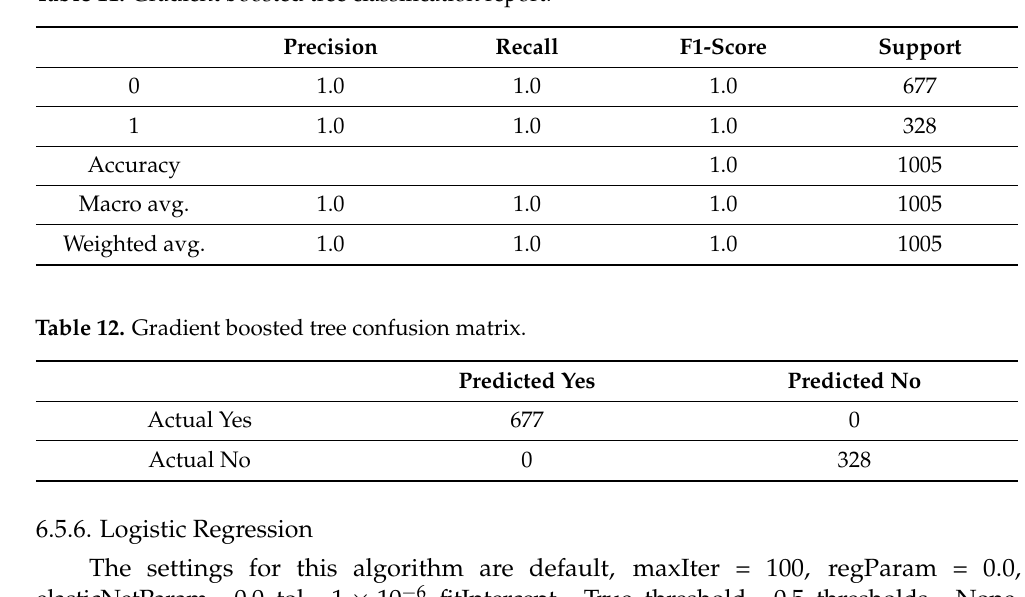
Table 11. Gradient boosted tree classification report.